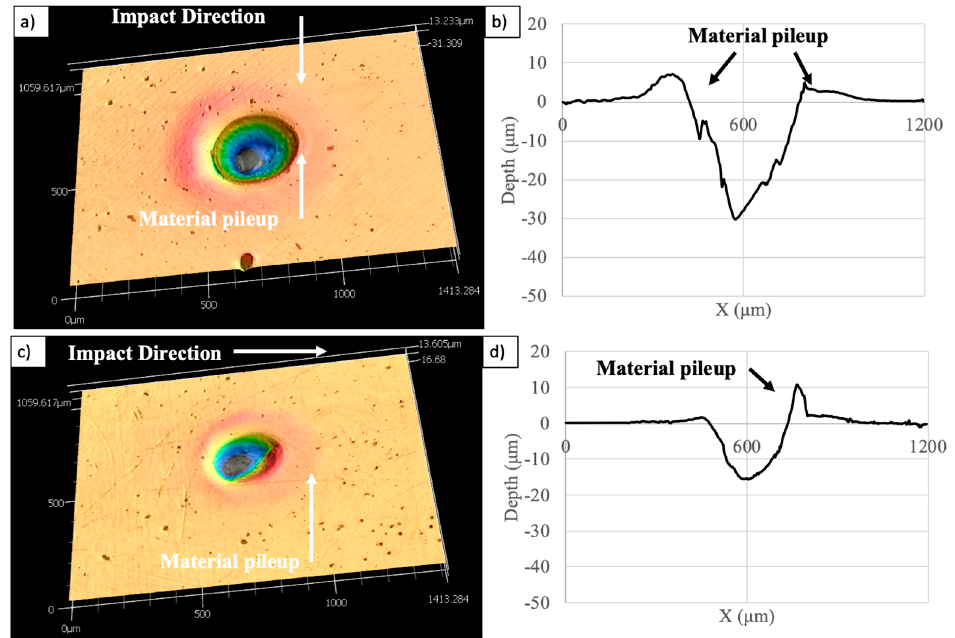
Figure 10. Monolayer of superelastic NiTi coating impacts profiles at a 90 ◦ ( a ) confocal ( b ) depth profile and at a 30 ◦ impacts ( c ) confocal and ( d ) depth